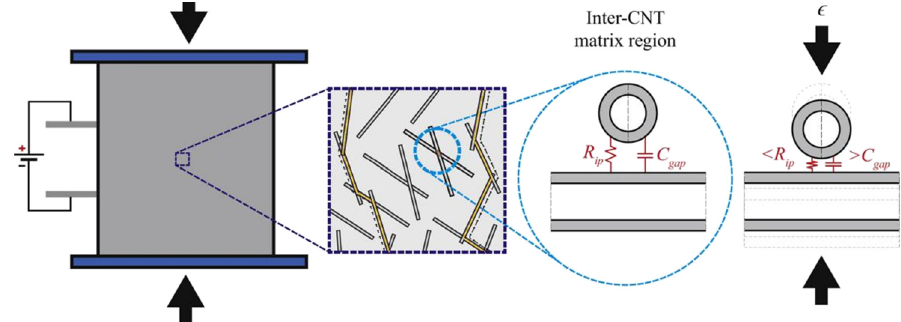
Figure 10: Microscopic model diagram of CNTCS composed of resistors and capacitors in parallel [ 122 ]